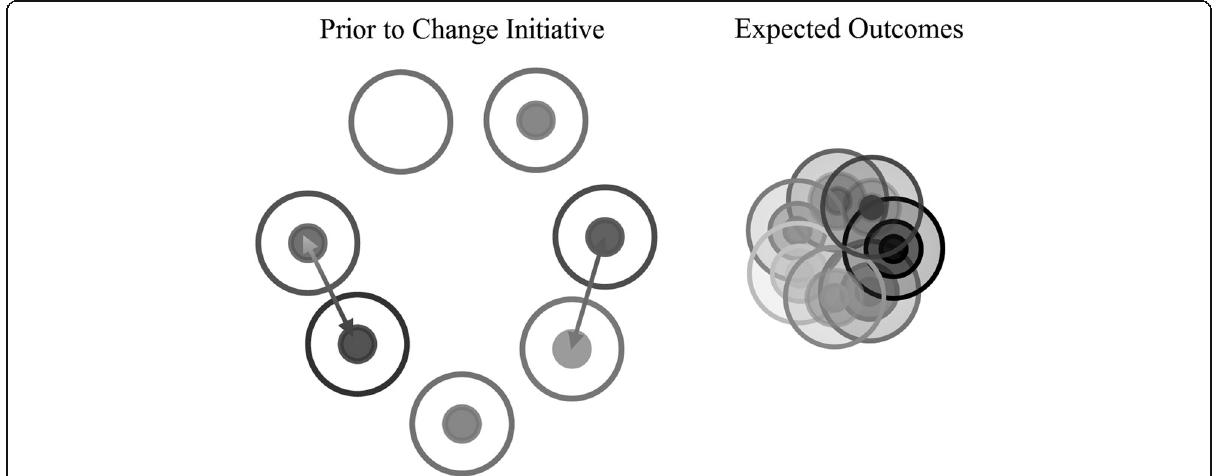
Fig. 1 Isolated units prior to change and the expected outcomes of overlapping communities of practice. Legend: units involved in the change initiative (as unfilled circles) with a core of education innovators (solid